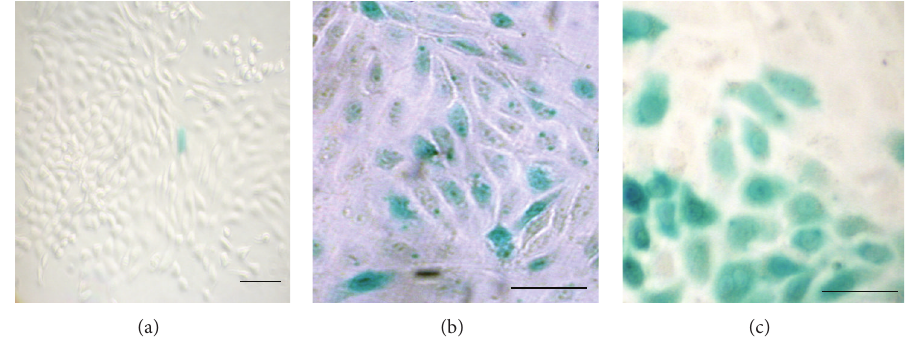
Figure 5: 𝛽 -catenin/TCF signaling in CD 24+ embryonic kidney cells in vitro . (a) CD 24+ cells isolated from E15 kidney of mice bearing the 𝛽 -catenin/TCF-lacZ transgene show minimal 𝛽 -galactosidase activity (blue) in baseline monolayer culture. (b) About 40% of CD exposed to murine L-cells expressing Wnt3a showed canonical 𝛽 -catenin/TCF signaling. (c) CD 24+ cells exposed to ureteric bud cells isolated by FACS from E15 Hoxb7 -GFP mice showed similar canonical 𝛽 -catenin/TCF signaling. Scale bar: 50 𝜇 m.